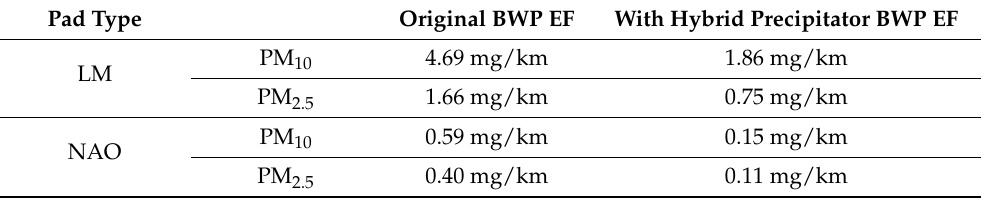
Table 1. Emission factor of BWPs when using LM or NAO pads in a brake system for the WLTP-brake.